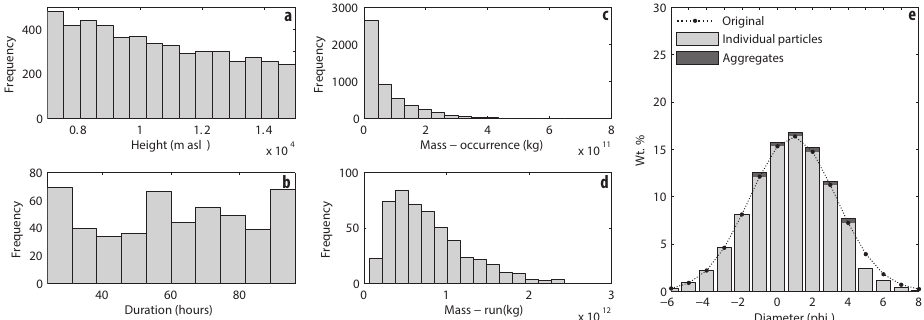
Figure 5. ESP for the Katla LLERS; (a) plume heights considering all occurrences (i.e. all model runs); (b) eruption duration; (c) erupted masses considering all occurrences; (d) erupted masses considering single runs; (e) example of a TGSD of a single run. See caption of Fig. 4 for explanation of